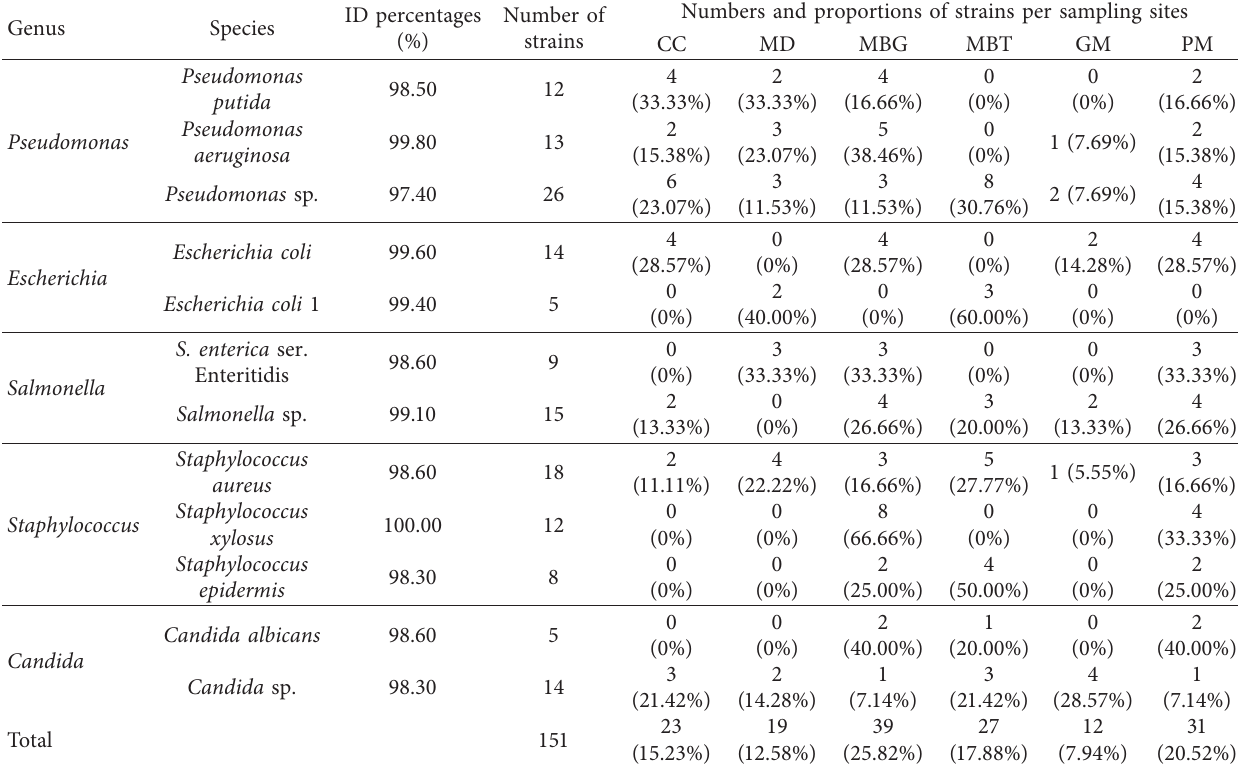
Table 2: Genus, species, identification percentages, and proportions of strains isolated from fresh beef samples collected from different markets of the city of